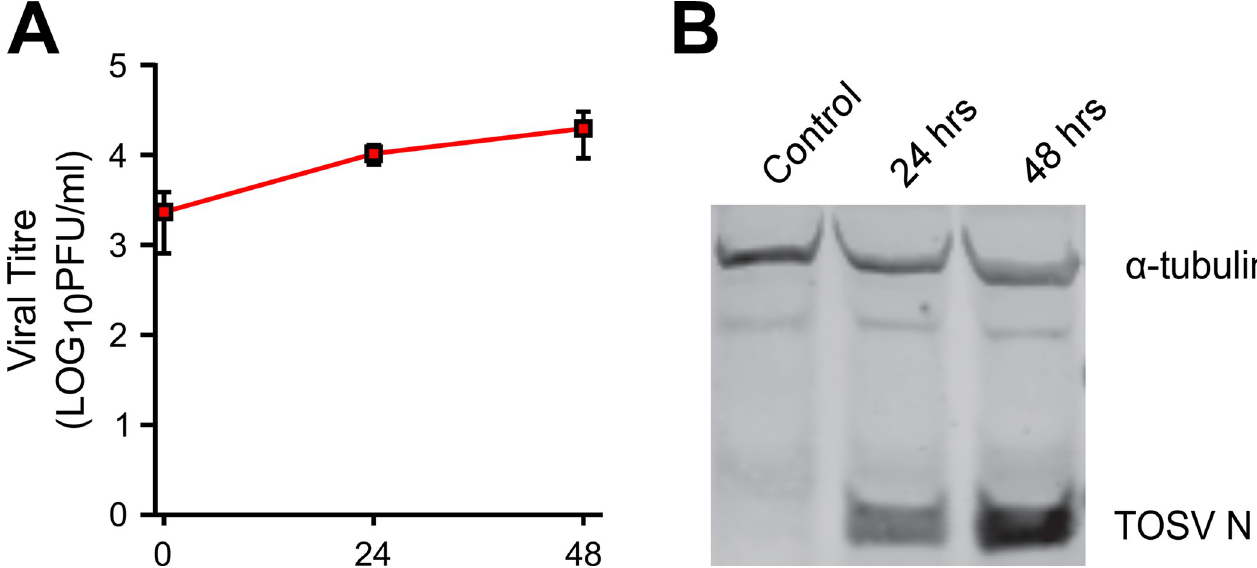
Fig 2. The PP9ad cell line is susceptible to rTOSV infection. (A) Titration of rTOSV following PP9ad infection with rTOSV (MOI 5 PFU/cell) up to 48 h post infection (h.p.i.). Mean titre with standard deviation (SD) of three samples are presented. (B) Protein lysates from rTOSV-infected PP9ad cells were assessed for the presence of N protein (TOSV N) by western botting at 24 and 48 h.p.i. α -Tubulin was used as a loading control. Figures are representative of two independent experiments; lysate from uninfected cells was used as negative control.